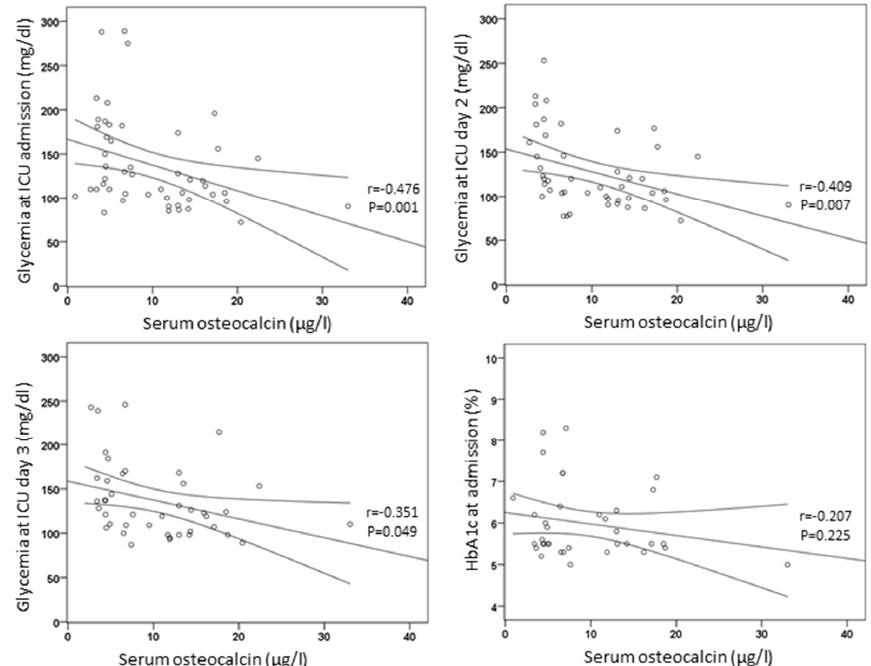
Figure 1. Correlations of circulating osteocalcin with glycemia and HbA1c.